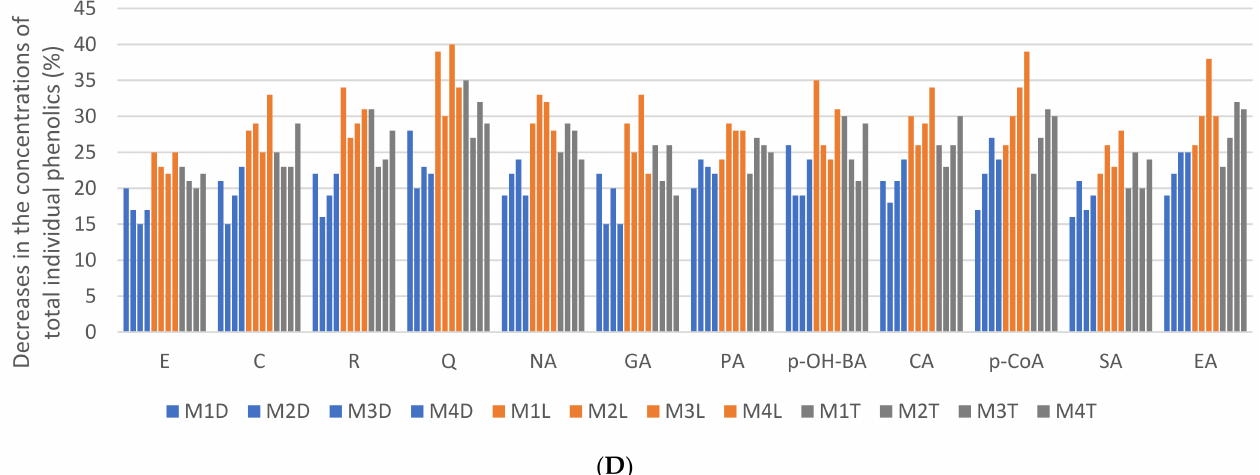
Figure 4. ( A ) Percentage decreases in the concentrations of free phenolics of the M1–M4 nutraceutical mixtures under the defined storage conditions: E (epicatechin), C (catechin), R (rutin), Q (quercetin), NA (neochlorogenic acid), GA (gallic acid), PA (protocatechuic acid), p- OH-BA- ( p- hydroxybenzoic acid), CA (caffeic acid), p- CoA ( p- coumaric acid), SA (sinapic acid), EA (ellagic acid), D (storage without sunlight, blue color), L (storage in the presence of sunlight, orange color), T (storage in thermostatic device, grey color). ( B ) Percentage decreases in the concentrations of soluble bound phenolics of the M1–M4 nutraceutical mixtures under the defined storage conditions: E (epicatechin), C (catechin), R (rutin), Q (quercetin), NA (neochlorogenic acid), GA (gallic acid), PA (protocatechuic acid), p- OH-BA- ( p- hydroxybenzoic acid), CA (caffeic acid), p- CoA ( p- coumaric acid), SA (sinapic acid), EA (ellagic acid), D (storage without sunlight, blue color), L (storage in the presence of sunlight, orange color), T (storage in thermostatic device, grey color). ( C ) Percentage decreases in the concentrations of insoluble bound phenolics of the M1–M4 nutraceutical mixtures under the defined storage conditions: E (epicatechin), C (catechin), R (rutin), Q (quercetin), NA (neochlorogenic acid), GA (gallic acid), PA (protocatechuic acid), p- OH-BA- ( p- hydroxybenzoic acid), CA (caffeic acid), p- CoA ( p- coumaric acid), SA (sinapic acid), EA (ellagic acid), D (storage without sunlight, blue color), L (storage in the presence of sunlight, orange color), T (storage in thermostatic device, grey color). ( D ) Percentage decreases in the concentrations of total phenolics of the M1–M4 nutraceutical mixtures under the defined storage conditions: E (epicatechin), C (catechin), R (rutin), Q (quercetin), NA (neochlorogenic acid), GA (gallic acid), PA (protocatechuic acid), p- OH-BA- ( p- hydroxybenzoic acid), CA (caffeic acid), p- CoA ( p- coumaric acid), SA (sinapic acid), EA (ellagic acid), D (storage without sunlight, blue color), L (storage in the presence of sunlight, orange color), T (storage in thermostatic device, grey